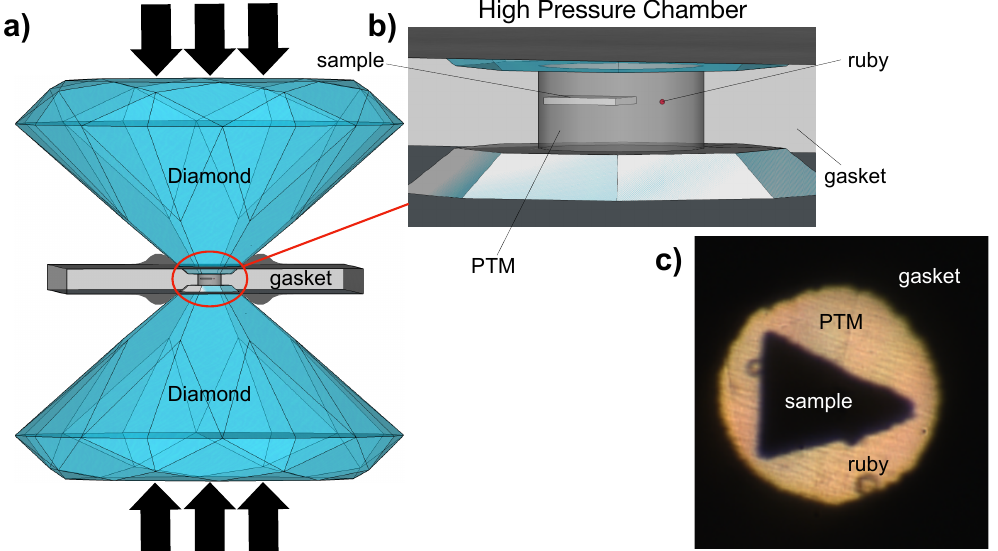
Figure 2. ( a ) Concept design of the DAC principle. A pre-indented metal gasket is squeezed between two diamond anvils along the direction indicated by the black arrows. ( b ) Zoom of the resulting high-pressure chamber containing the sample, the PTM and a pressure gauge (ruby). ( c ) Real image obtained from the top view of the high-pressure chamber of a loaded